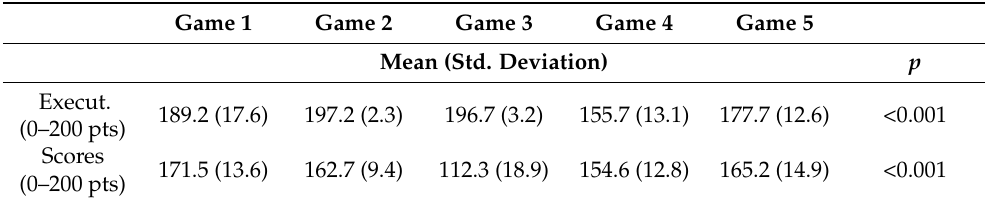
Table 3. Differences between virtual reality games in the execution/quality of the exercise performed and the final punctuation achieved.